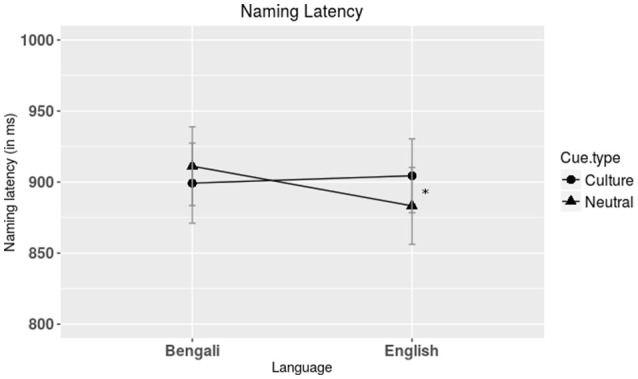
Plot showing response times for L1 and L2 naming against cultural and neutral cues. The culture cue facilitated L1 naming and inhibited L2 naming, compared to neutral cue. Note: *p < 0.01.